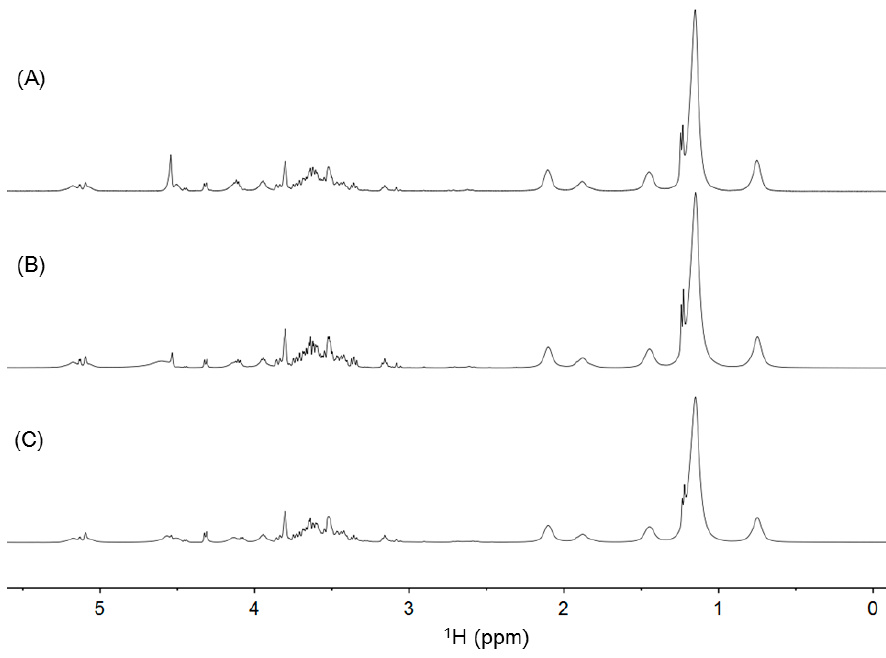
Figure 5. The 1 H NMR spectra of the ready yogurt measured at 40 °C in different lots.